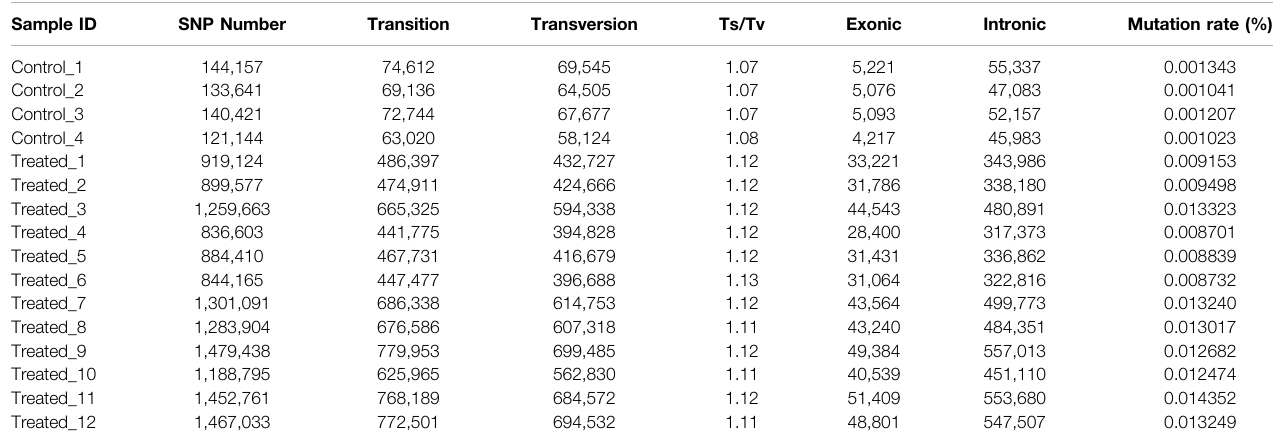
TABLE 5 | SNP number in the control and EMS treated group after removing shared types with